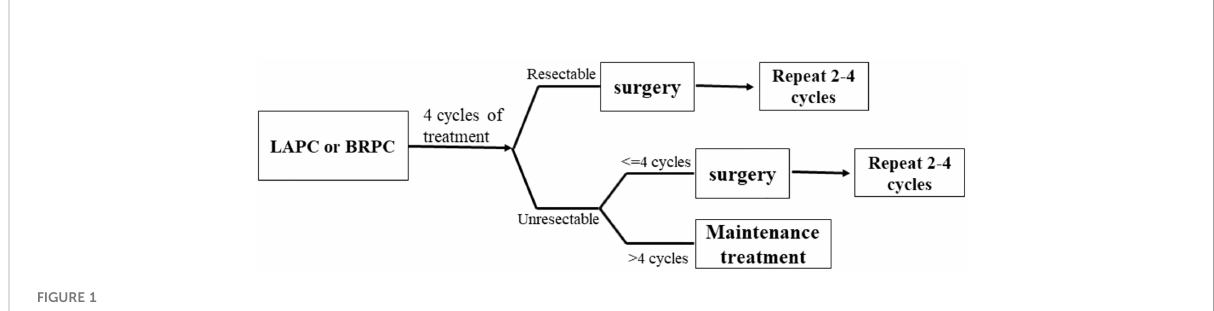
FIGURE 1 The process of the clinical